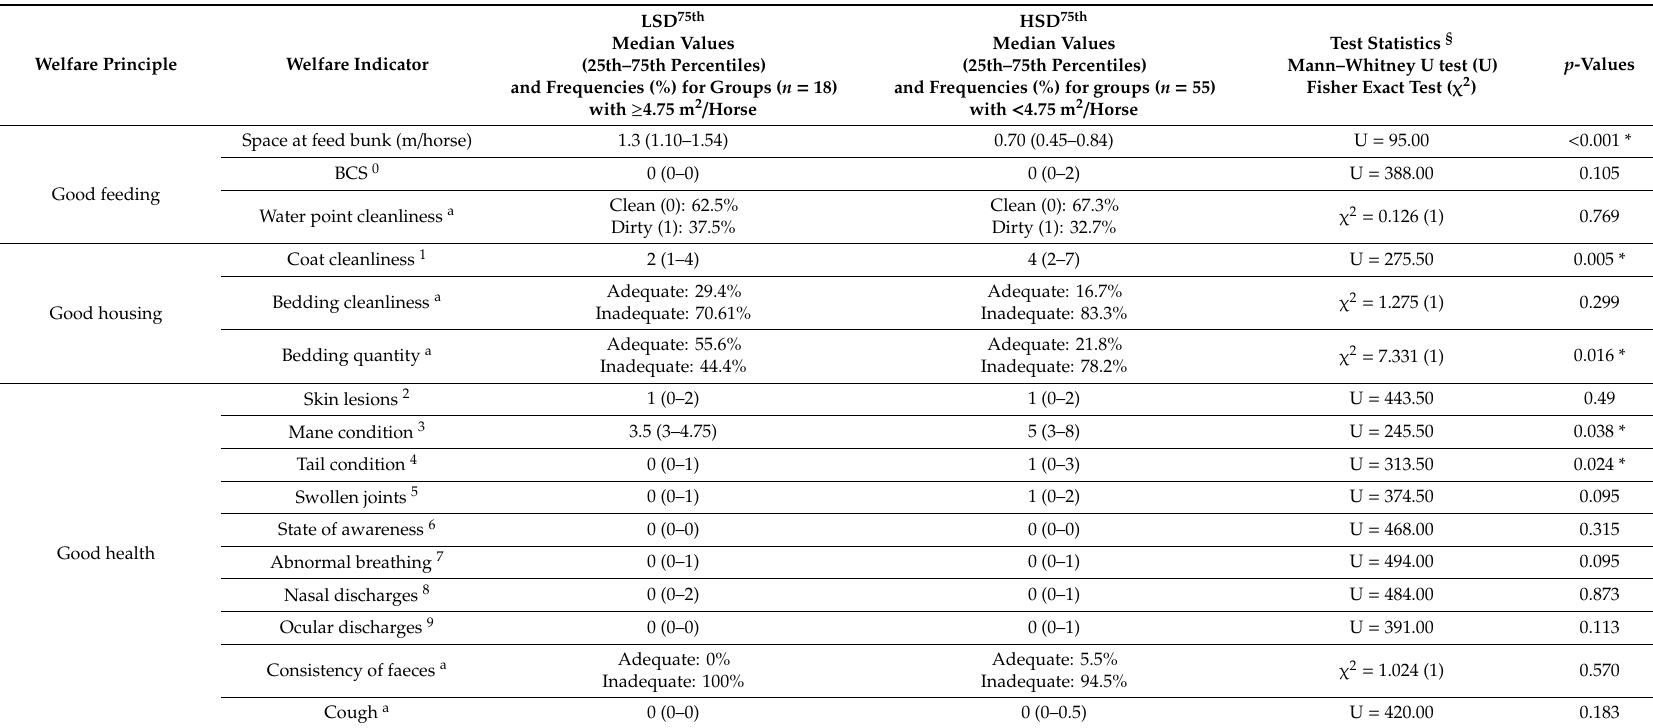
Table 4. Statistical analysis performed using the 75th percentile cut-o ff value (4.75 m 2 / horse). Nondichotomous variables are expressed as the median number of horses (plus 25th–75th percentiles) presenting a specific score or health condition or performing a specific behaviour. Space at the feed bunk is expressed as median (plus 25th–75th percentiles) length in metres available per horse. Nondichotomous variables were analysed using the Mann–Whitney U test: test statistic (U) and p -values are reported. Dichotomous variables are expressed as frequencies (%) and were analysed using the Fisher exact test: the test statistic ( χ 2 ), degrees of freedom and p -values are reported. Data were considered significant for p -values <